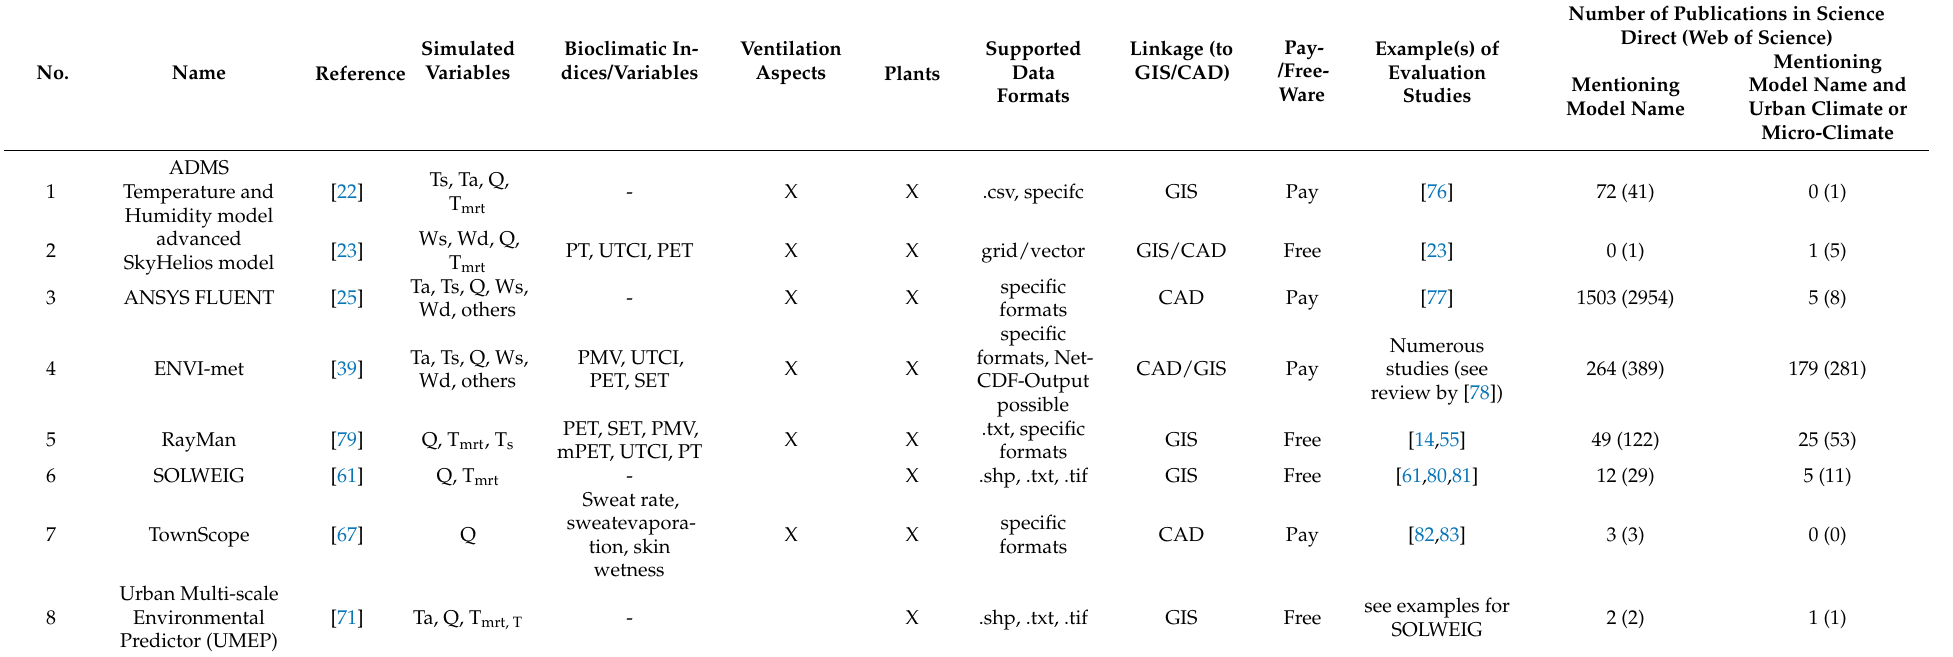
The abbreviations for simulated variables are Ts: surface temperature, Ta: air temperature, Q: long- and short-wave radiation, T mrt : mean radiant temperature, Ws: wind speed, and Wd: wind direction. For the bioclimatic indices PT: Perceived Temperature, UTCI: Universal Thermal Climate Index, PET: Physiological Equivalent Temperature, mPET: modified Physiological Equivalent Temperature, SET: Standard Effective Temperature, and PMV: Predicted Mean